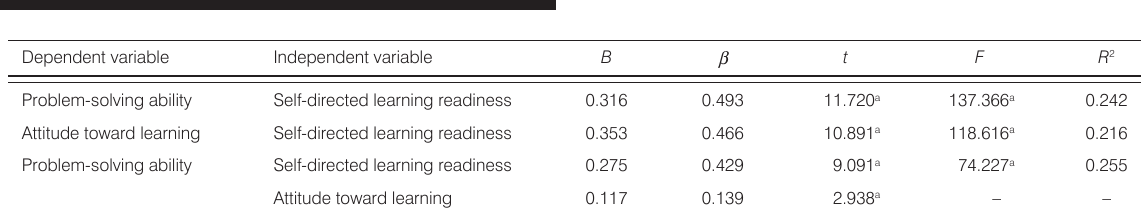
Table 4. Hierarchical regression analysis ( N =429).